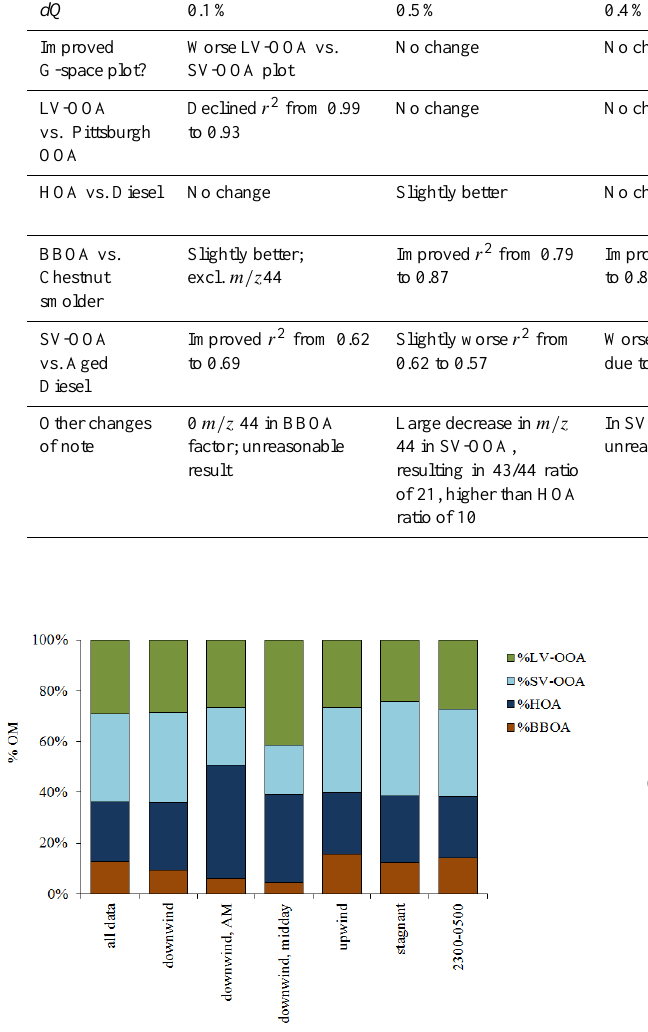
Figure 10. Attribution of OM by factor in the four-factor solution over all data, during 3 Fig. 10. Attribution of OM by factor in the four-factor solution downwind conditions only, during downwind conditions between 0500 and 0900 LST only, 4 over all data, during downwind conditions only, during downwind conditions between 05:00 and 09:00 LST only, during downwind during downwind conditions midday, during upwind conditions only, during stagnant conditions, 5 conditions midday, during upwind conditions only, during stagnant and during 2300-0500 LST only. 6 conditions, and during 23:00–05:00 LST